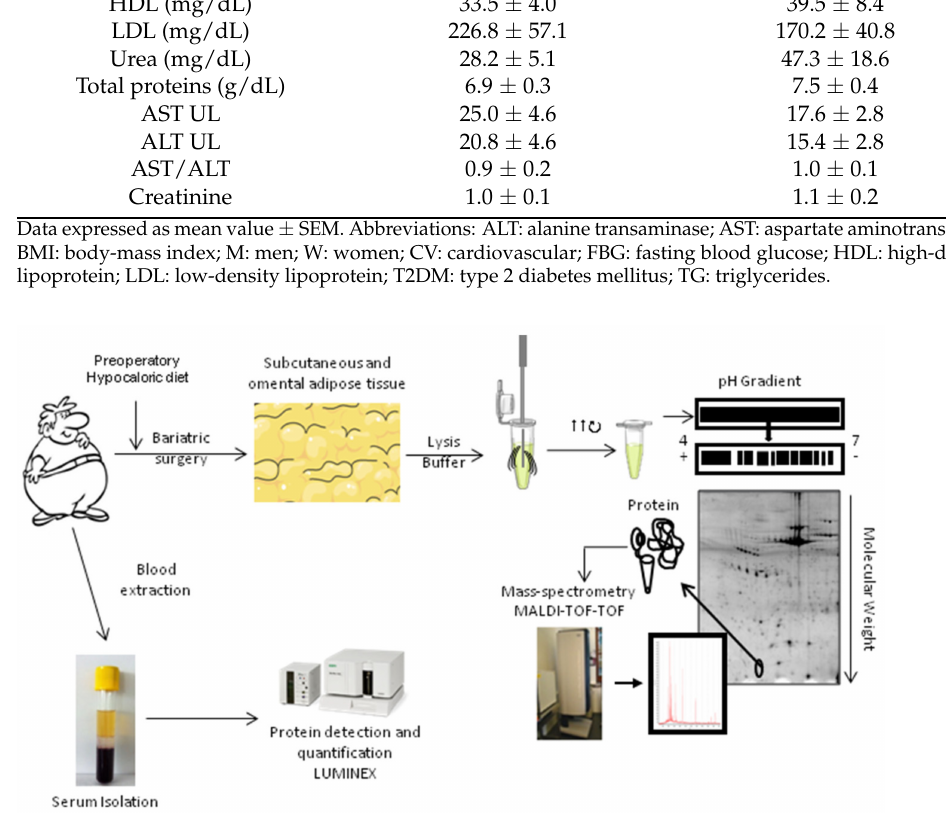
Figure 6. Study design. SAT and VAT from obese class III individuals (with or without T2DM) were collected. Proteins were extracted with a lysis buffer and a proteomic approach was used to identify changes in the proteomic profile due to fat location or due to the presence of